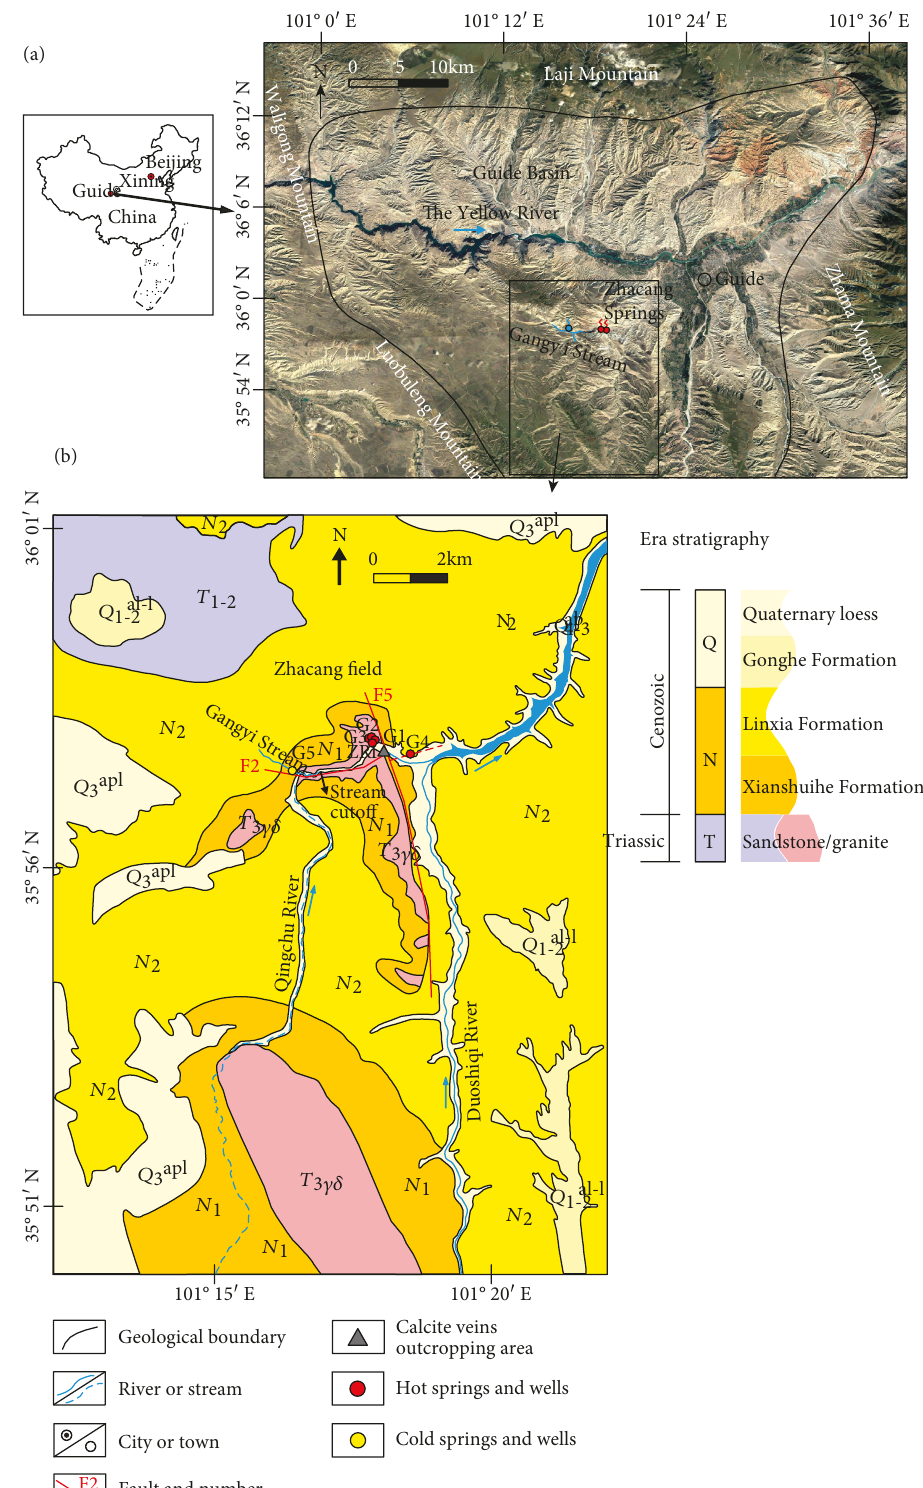
Figure 1: (a) Landform of the Guide Basin and (b) the geological map of the Zhacang geothermal fi eld and sampling locations. A total of 6 water samples were collected with the numbers of ZR1, G1, G2, G3, G4, and G5. The solid red lines on (b) correspond to the faults, and the W- E trending fault of F2 is conductive and the N-S trending fault of F5 is impermeable. Hot springs discharge at the junction of F2 and